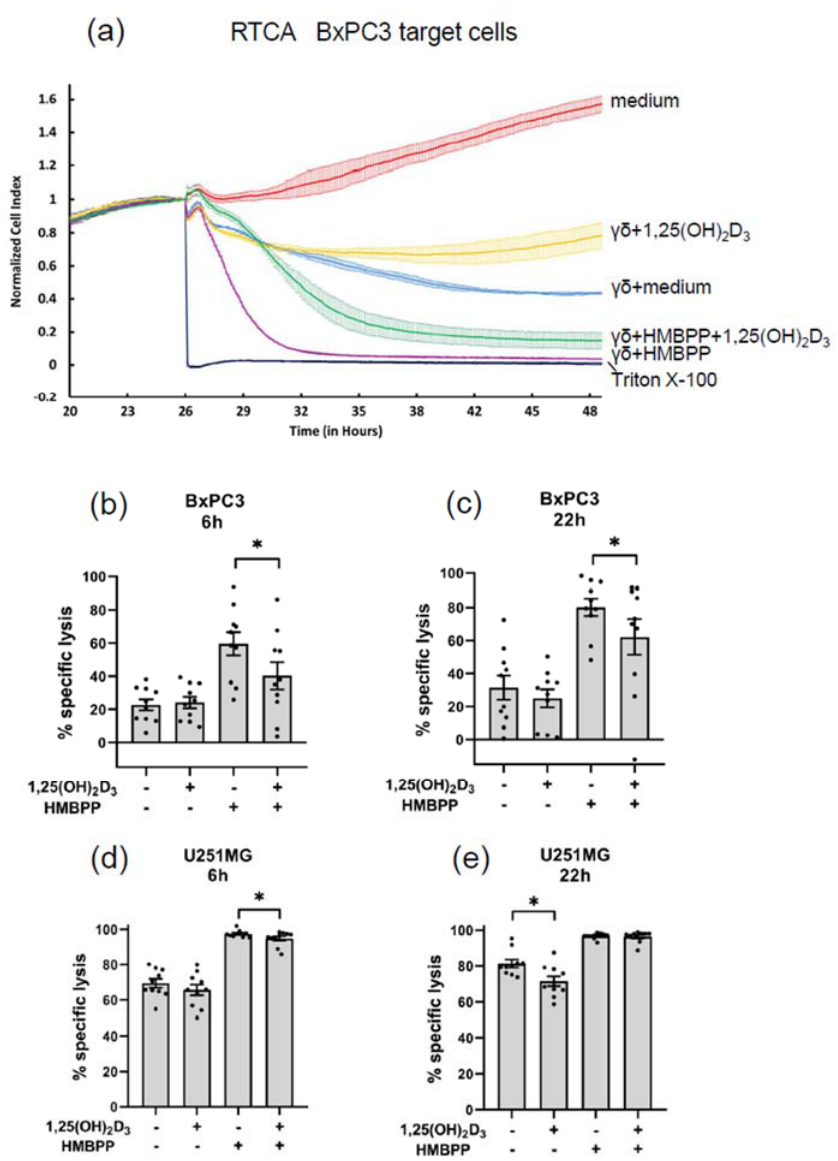
Figure 6. Cytotoxic activity of γδ T cells expanded in the absence or presence of 1,25(OH) 2 D 3 . V δ 2 T cell lines expanded for 14 d from ZOL-stimulated PBMC in the absence or presence of 50 nM 1,25(OH) 2 D 3 were used as effector cells (E/T ratio 10:1) in the RTCA with BxPC3 ( a – c ) or U251MG target cells ( d , e ). Where indicated, HMBPP was added at a final concentration of 10 nM. The impedance was continuously recorded over 48 h beginning with the addition of tumor cells. Effector cells were added at time point 26 h, and the % specific lysis was calculated in relation to spontaneous tumor cell growth and Triton X-100 induced maximal lysis at 6 h and 22 h after addition of effector cells, based on the normalized cell index, which was set to 1 at the time when effector cells were added. ( a ) RTCA plot with one V δ 2 effector cell population and BxPC3 tumor target cells. ( b , c ) Specific lysis of BxPC3 target cells at 6 h ( b ) and 22 h ( c ) by control or 1,25(OH) 2 D 3 -expanded V δ 2 effector T cells in the absence or presence of HMBPP. ( d , e ) Specific lysis of U251MG target cells at 6 h ( d ) and 22 h ( e ) by control or 1,25(OH) 2 D 3 -expanded V δ 2 effector T cells in the absence or presence of HMBPP. Mean ± SEM of experiments with 10 different V δ 2 T cell lines is shown. Statistical significance was analyzed by the Wilcoxon matched pairs signed-rank test. * p <